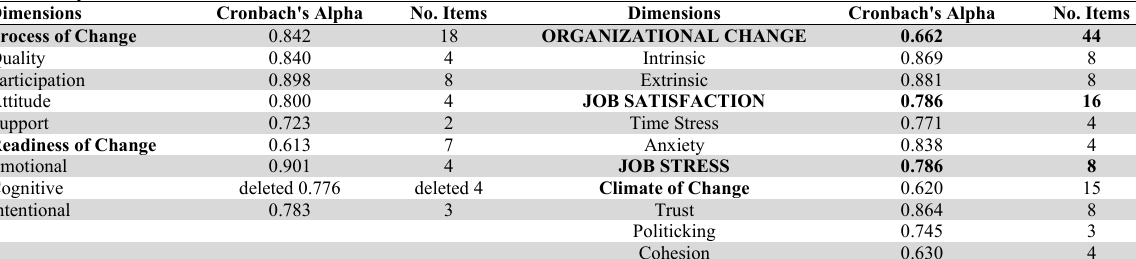
Reliability of Overall